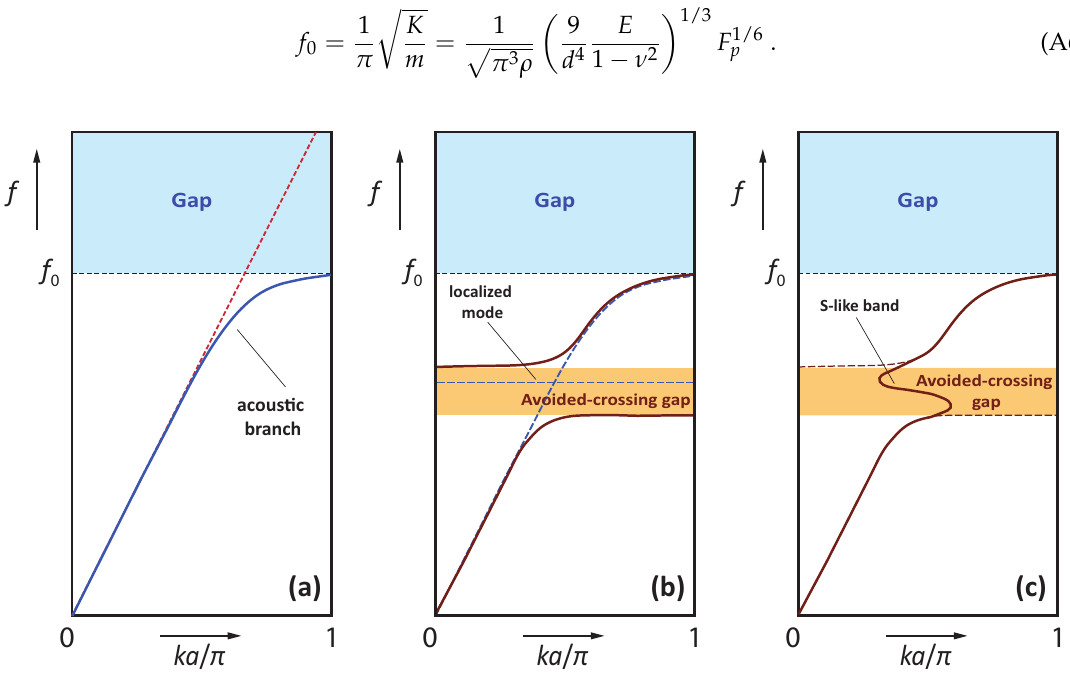
Figure A2. ( a ) schematic representation of the dispersion relation for a periodic mass-spring array of lattice constant a . The acoustic branch (solid line) is perfectly described, at the long-wavelength limit, by a linear dispersion corresponding to an effective-medium propagation velocity c ef f = π af 0 (broken line), while the cut-off frequency f 0 delimits the lower frequency limit of the extended to infinity band gap (shaded area); ( b ) as in ( a ) but with the presence of a localized flat mode which, after interaction with the acoustic branch of the chain’s dispersion relation, gives rise to an avoided-crossing gap (shaded area) below the cut-off frequency. Broken lines: the bands before hybridization; ( c ) modification of the dispersion plot shown in ( b ) when absorption is taken into account (see text) leading to an S-like band within the avoided-gap region, which corresponds to modes with complex